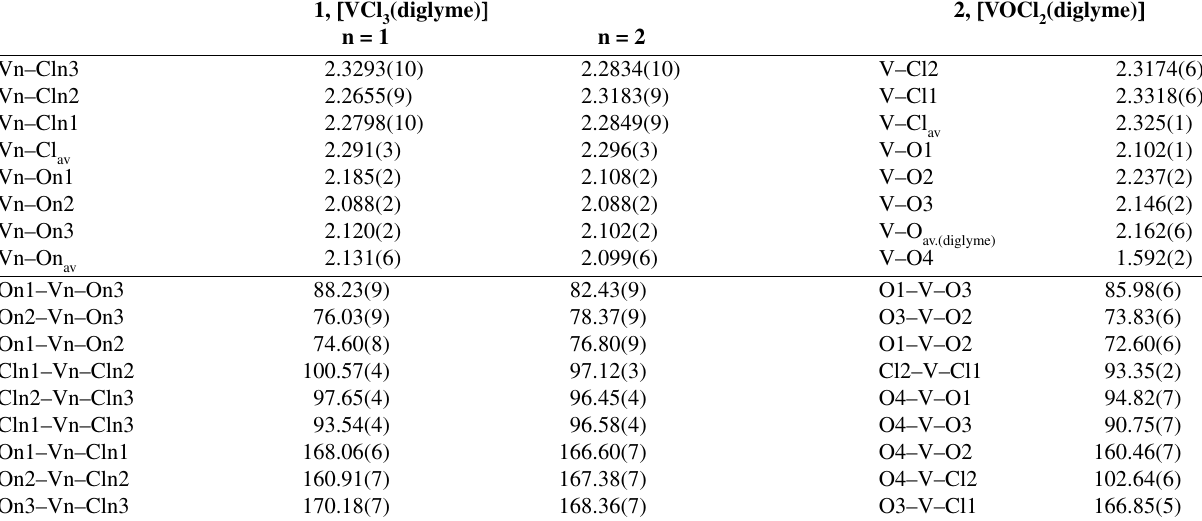
(diglyme) ] , and 2 , [ VOCl 3 1, [[ VCl (diglyme) ]] 3